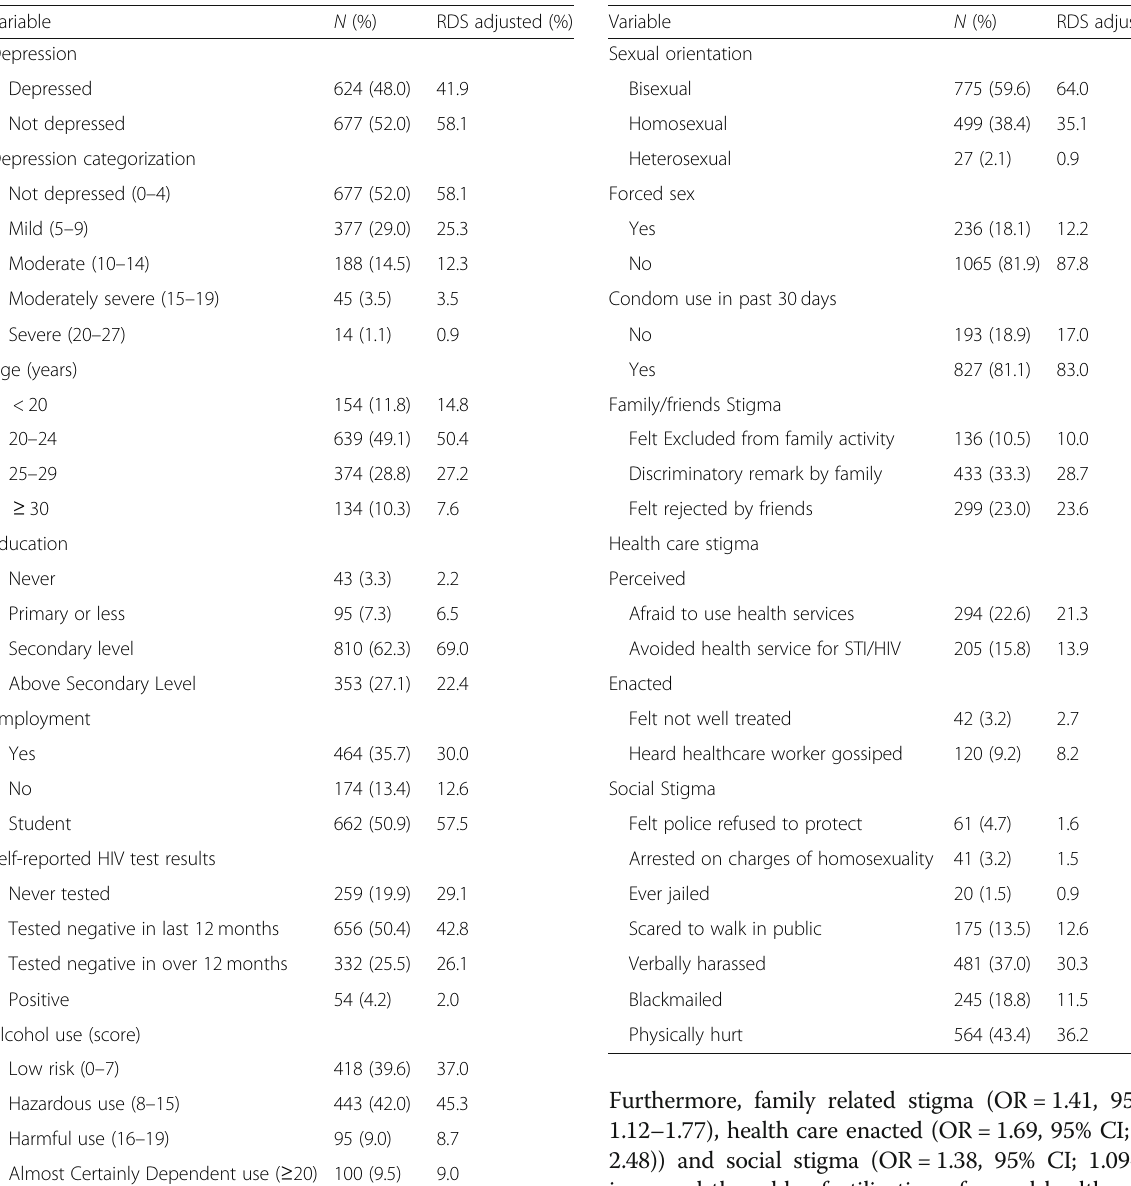
Table 1 Prevalence of variables of interest among MSM in Cote